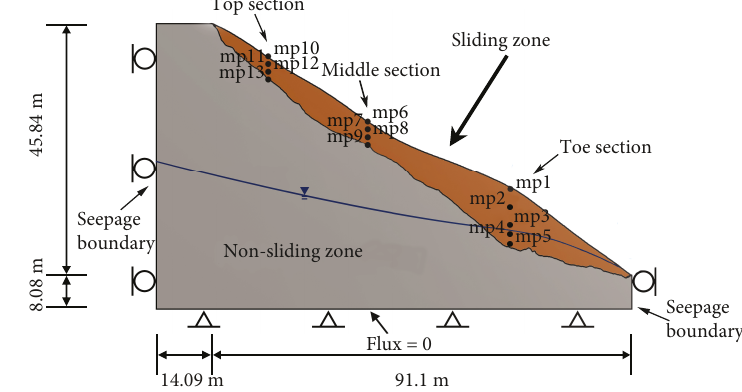
Figure 4: The slope geometry and boundary conditions.